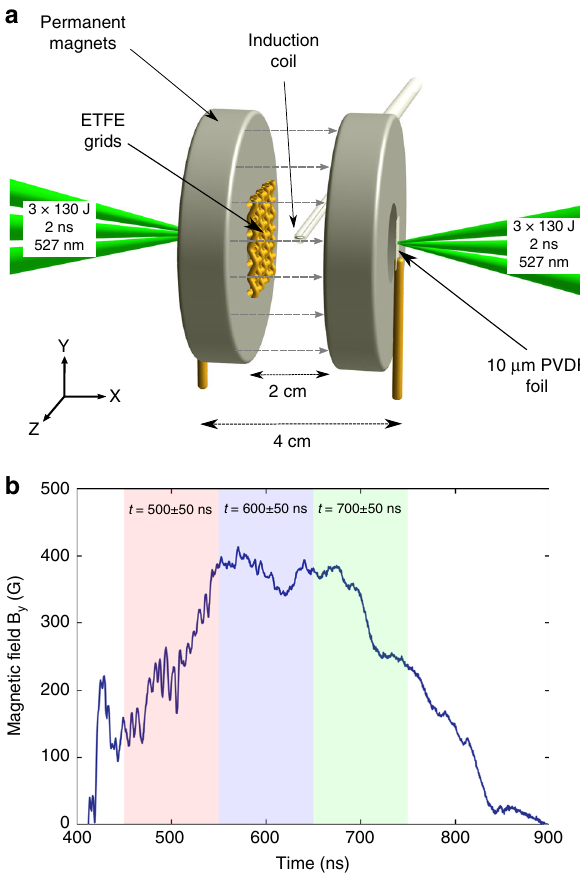
Fig. 1 Experimental con fi guration and magnetic- fi eld fl uctuations. a Experimental con fi guration. Two counter-propagating supersonic jets are launched by means of optical-laser ablation of thin fl uorinated plastic foils separated by 4 cm. Each foil is irradiated by three frequency-doubled (527-nm-wavelength) lasers, each carrying 130 ± 20 J of energy in a 2 ns pulse. The jets are passed through two misaligned plastic grids and collide, forming a central region of supersonic turbulence. Magnetic fl uctuations, created as the magnetic fi eld imposed by external permanent magnets (gray dashed lines) is advected by the fl ow, are measured with an induction coil and used to deduce velocity fl uctuations. b Temporal evolution of the y -component (vertical in the top panel) of the magnetic fi eld, as measured by the induction loop. The shaded regions represent the intervals over which the FFT was performed in calculating the magnetic- fi eld power